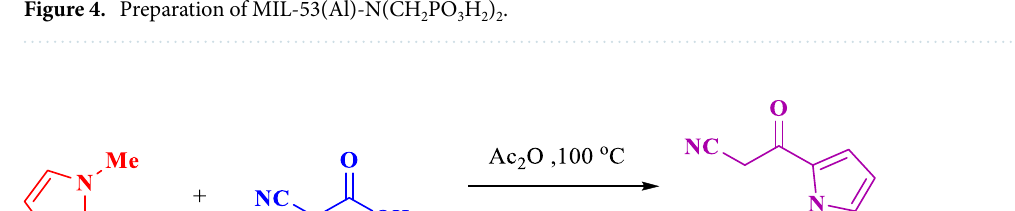
Figure 4. Preparation of MIL-53(Al)-N(CH 2 PO 3 H 2 ) 2 .